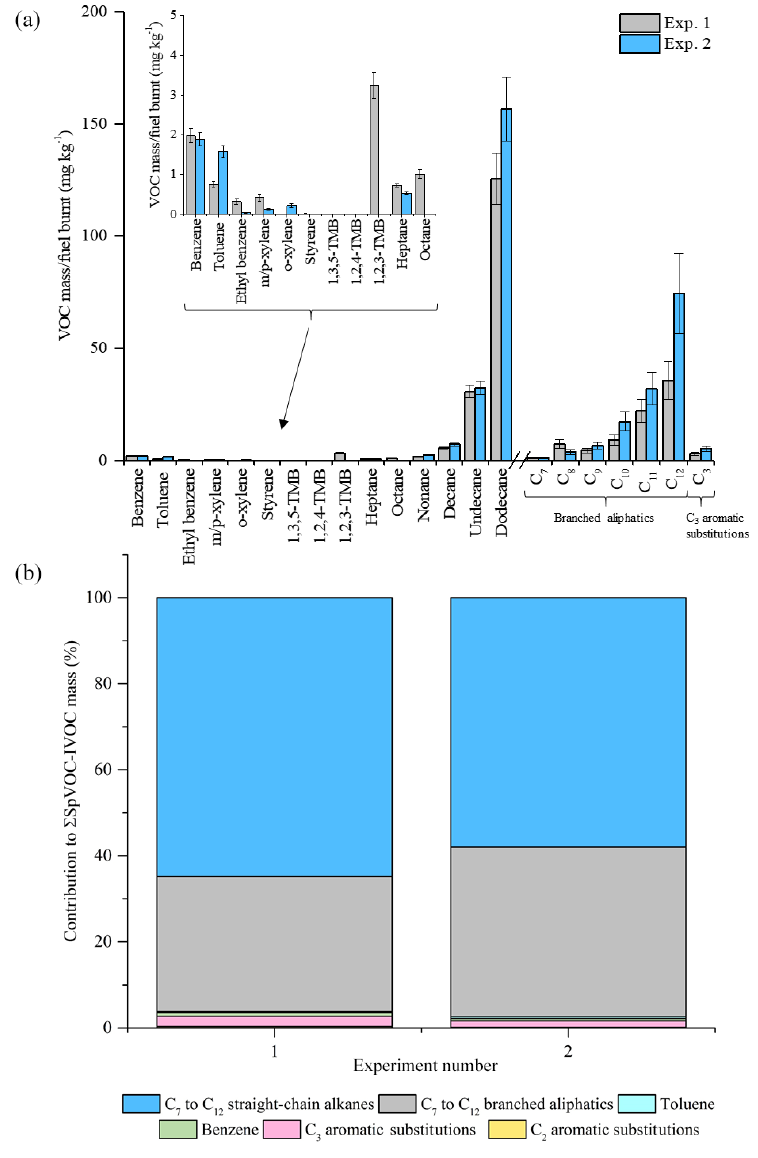
Figure 5. Comparison of measured VOC-IVOC emission rates in replicate warm high-load experiments 1 and 2 (exps. 1 and 2, 2500rpm, 40% load) (a) . Comparison of the percentage contribution of the individual and grouped compounds to the P SpVOC-IVOC emission rates in exps. 1 and 2 (b) . The emission rates of tridecane and the C 13 branched aliphatic grouping has not been included in (b) to allow direct comparison between other experiments where these species were not measured. Error bars represent the calculated uncertainty in the measured emission rates, see Sect. S1.1 for further